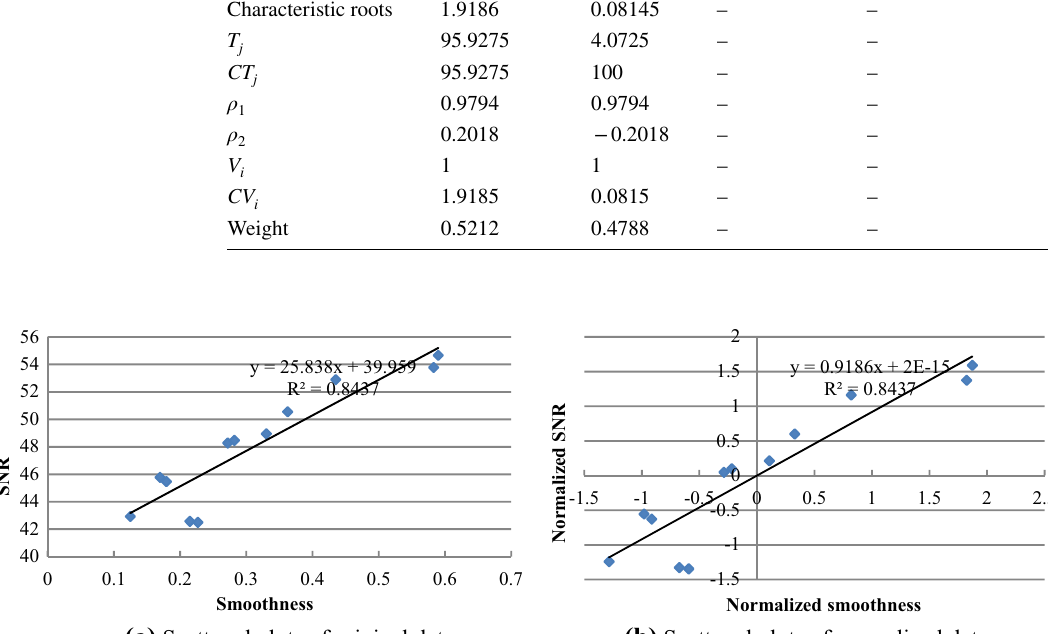
(a) Scattered plots of original data; (b) Scattered plots of normalized data Fig. 6 Scattered plots of pressure data. a Scattered plots of original data. b Scattered plots of normalized